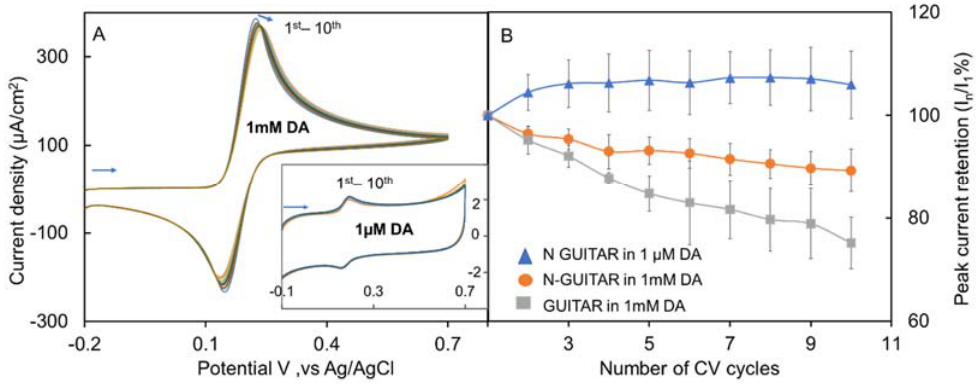
Figure 9. ( A ) 10 CV cycles recorded in 1 mM and (inset) 1 µ M dopamine in 0.1 M phosphate bu ff er system (PBS) at pH 7.0 at 100 mV / sec for N-GUITAR electrode. ( B ) Plot of relative oxidative peak current density vs. number of CV runs. The one standard deviation interval for three CV runs are shown with each data point.